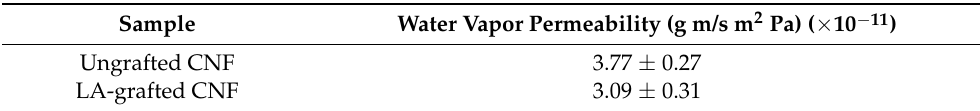
Table 4. Water vapor permeability of CNF and lactic acid-grafted CNF films.